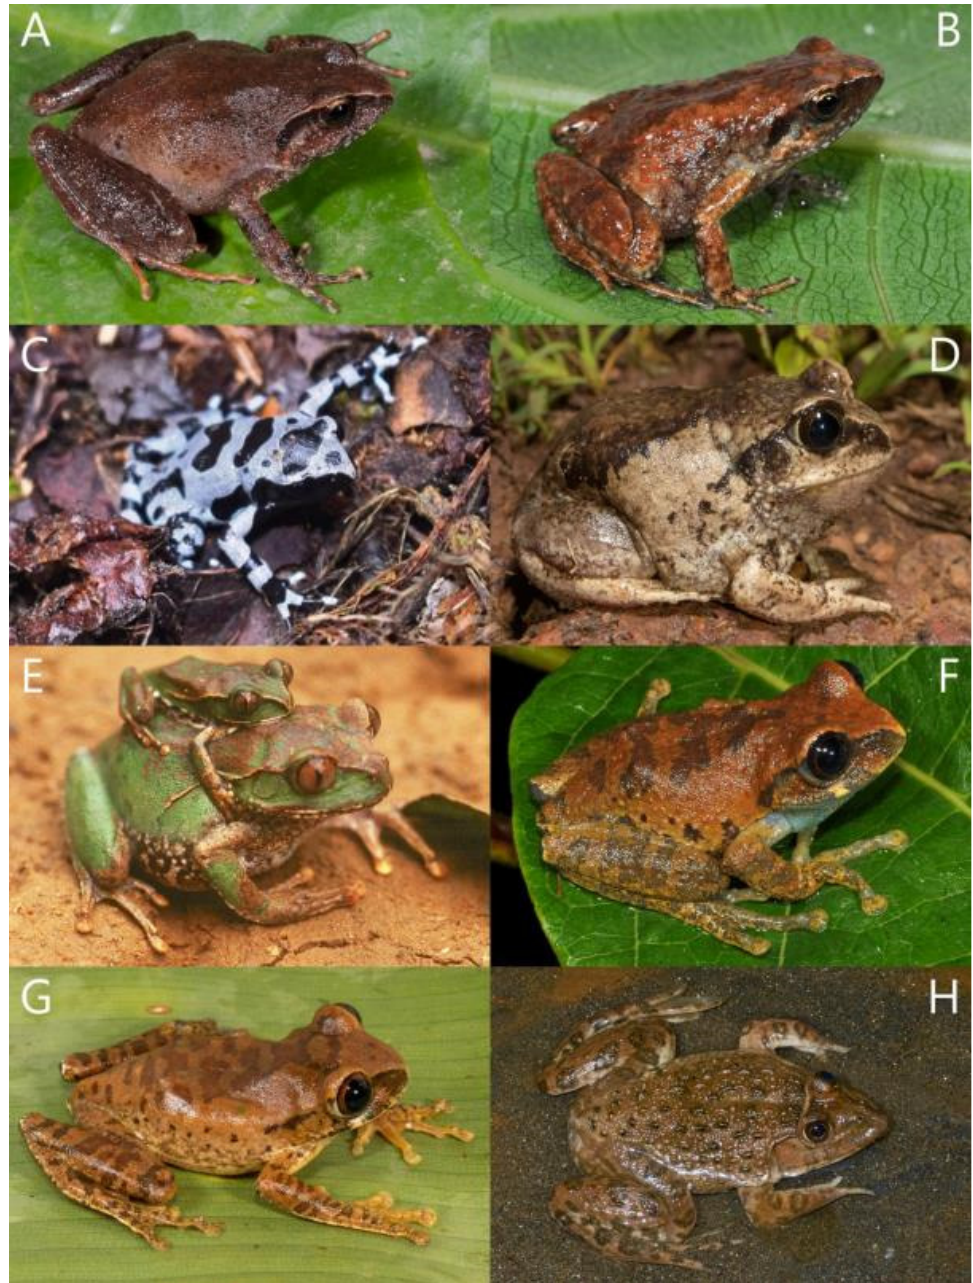
Figure 2. Rwandan species of Arthroleptidae ( A ) Arthroleptis adolfifriedrici , Gishwati-Mukura NP (photo: J.M.D.), ( B ) Arthroleptis schubotzi , Nyungwe NP (photo: J.M.D.), ( C ) Cardioglossa cyaneospila , Nyungwe NP (photo: Protais Niyigaba), ( D ) Leptopelis bocagii , Akagera NP (photo: J.M.D.), ( E ) Leptopelis cf. cynnamomeus , Cyamudongo Forest (photo: Eberhard Fischer), ( F ) Leptopelis karissimbensis , Nyungwe NP (photo: J.M.D.), ( G ) Leptopelis kivuensis , Nyungwe NP (photo: J.M.D.); and Dicroglossidae ( H ) Hoplobatrachus occipitalis , Bugarama (photo: J.M.D.).